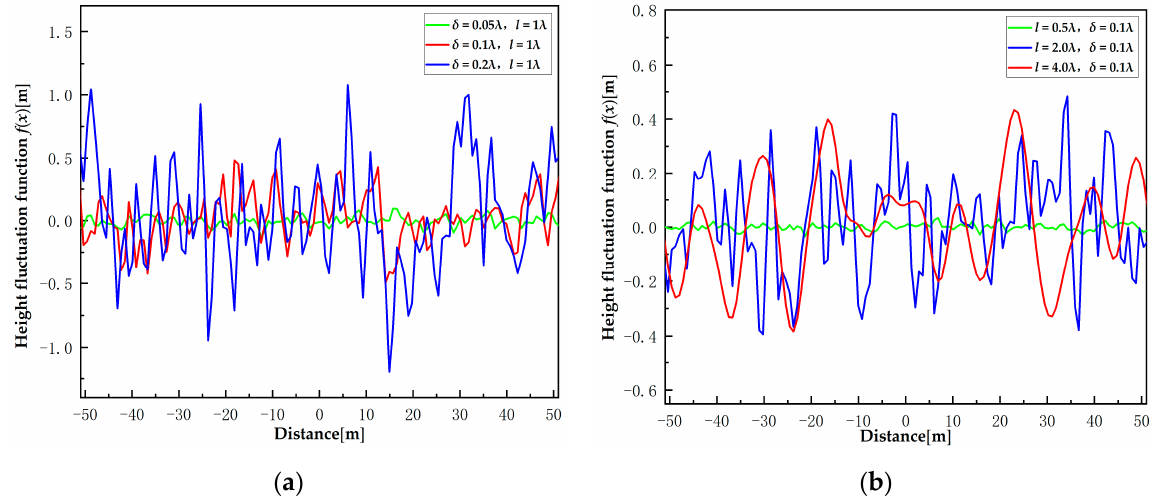
Figure 2. One dimensional Gaussian rough surface with different RMS heights and relevant lengths. ( a ) Different RMS heights; ( b ) Different relevant lengths.